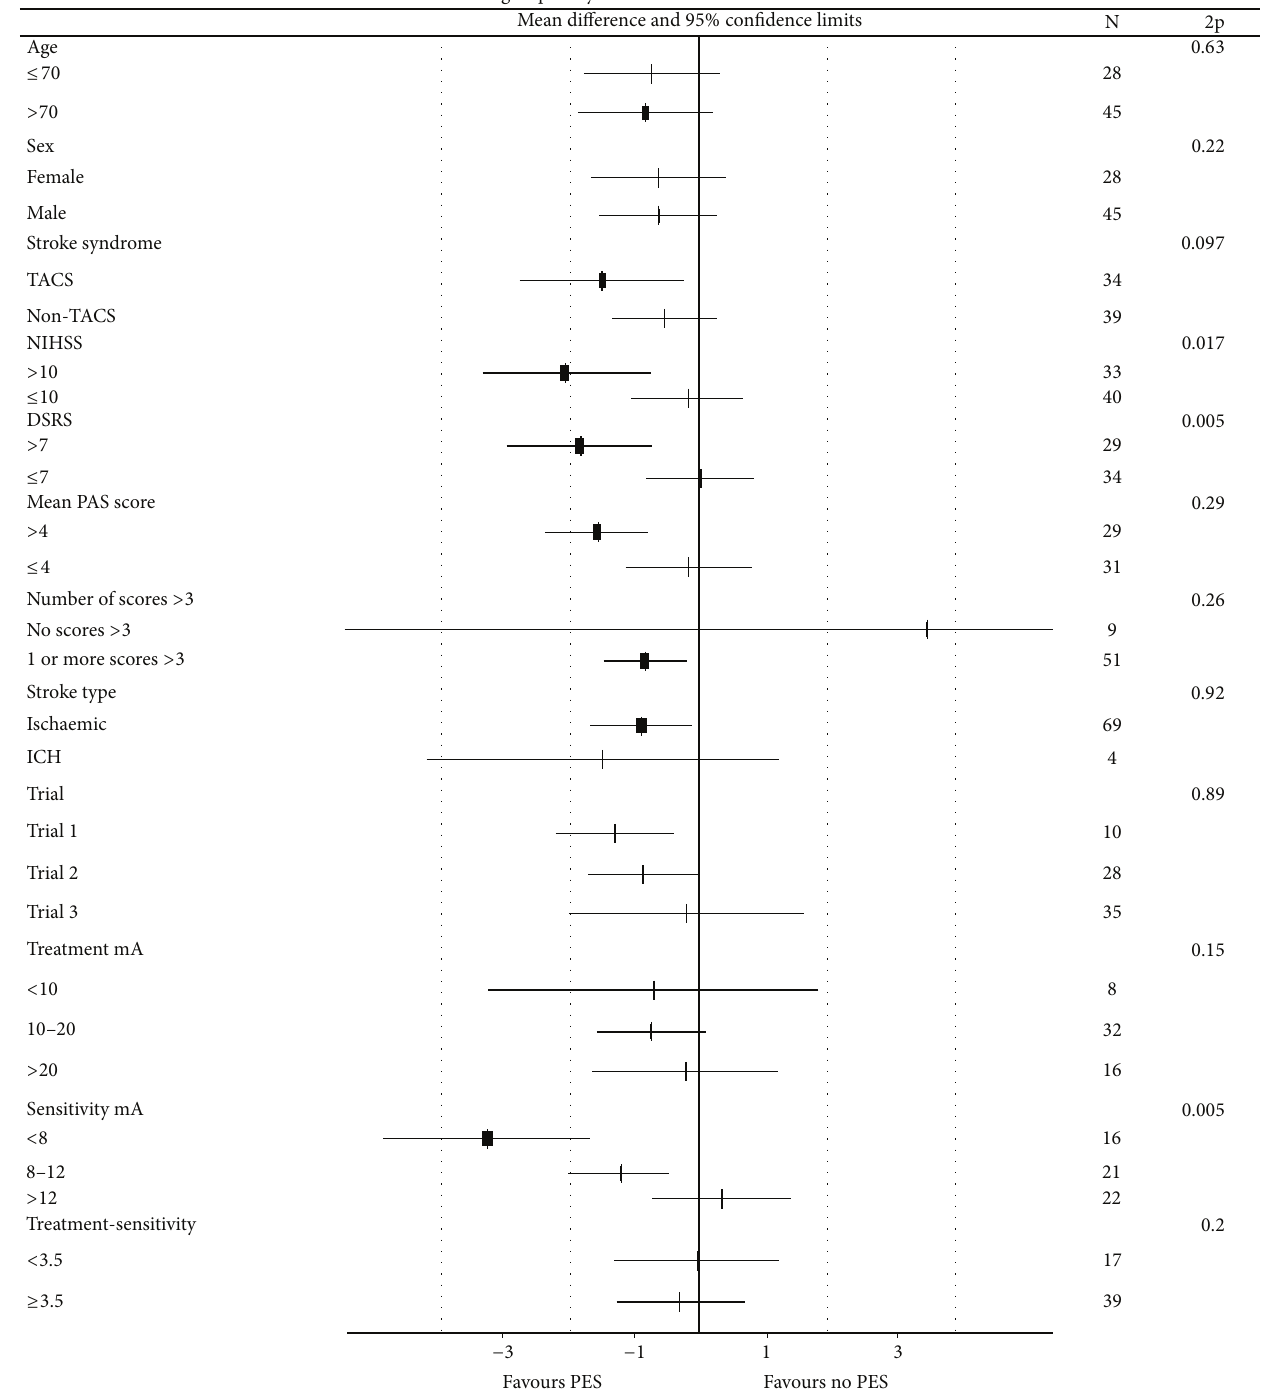
Figure 2: Mean penetration aspiration score, in subgroups: Age ( ≤ 70, > 70), sex (female, male), stroke syndrome (non-TACS, TACS), stroke severity (NIHSS ≤ 10, > 10), stroke type (IS, ICH); DSRS ( ≤ 7, > 7), mean PAS ( ≤ 4, > 4), number PAS > 3 (0, > 0), trial (1, 2, and 3), treatment current ( < 10, 10–20, and > 20 mA), sensitivity current ( < 8, 8–12, and > 12mA), treatment-sensitivity current ( < 3.5, ≥ 3.5 mA). Interaction tests adjusted for trial, age, and baseline NIHSS and